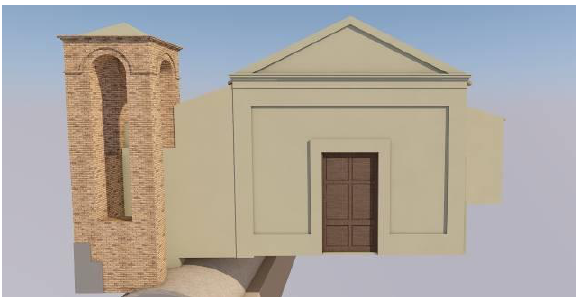
Figure 8. Reconstruction of Building Information Model